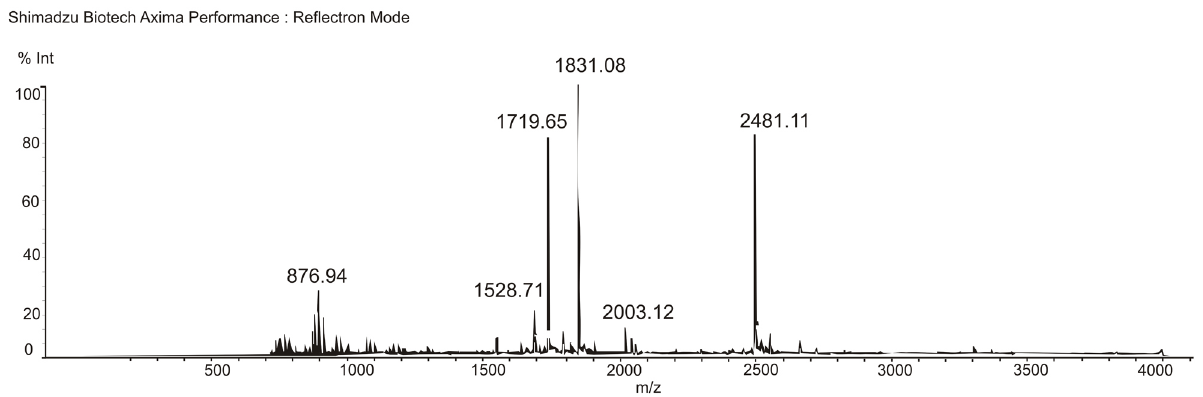
Figure 3. Peptide mass fingerprint spectrum from Matrix Assisted Laser Desorption Ionization (MALDI-ToF- ToF) mass spectrometry (AXIMA Performance®, Shimadzu, Japan). Each ion is a peptide fragment from a protein digested with a proteolytic enzyme.